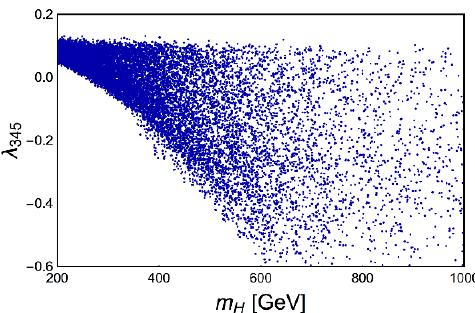
Figure 10 . (a) Correlation between m H and f and (b) mass splittings in the case of an exact C 2 symmetric scenario.